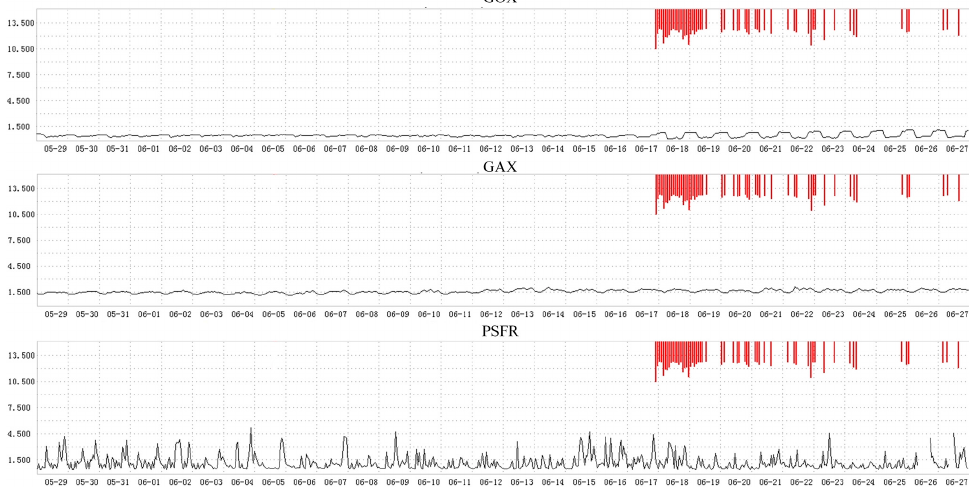
4 Figure 4. Electromagnetic signals from three stations near the Yibin earthquake. The red line at the top of the figure indicates the main shock and the aftershocks that